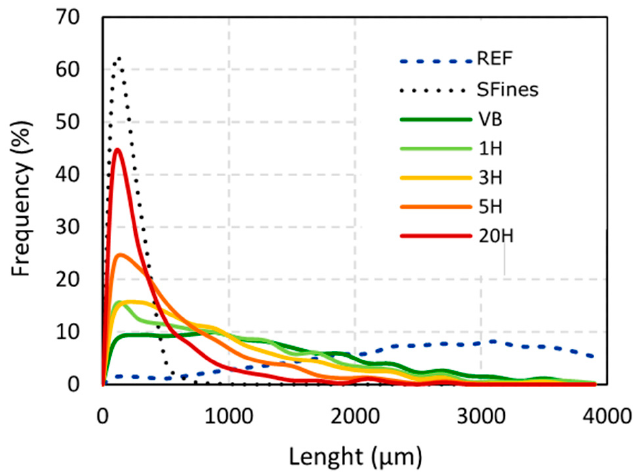
Figure 2. Average distribution of length of the different materials obtained using L&W Fiber Tester+.